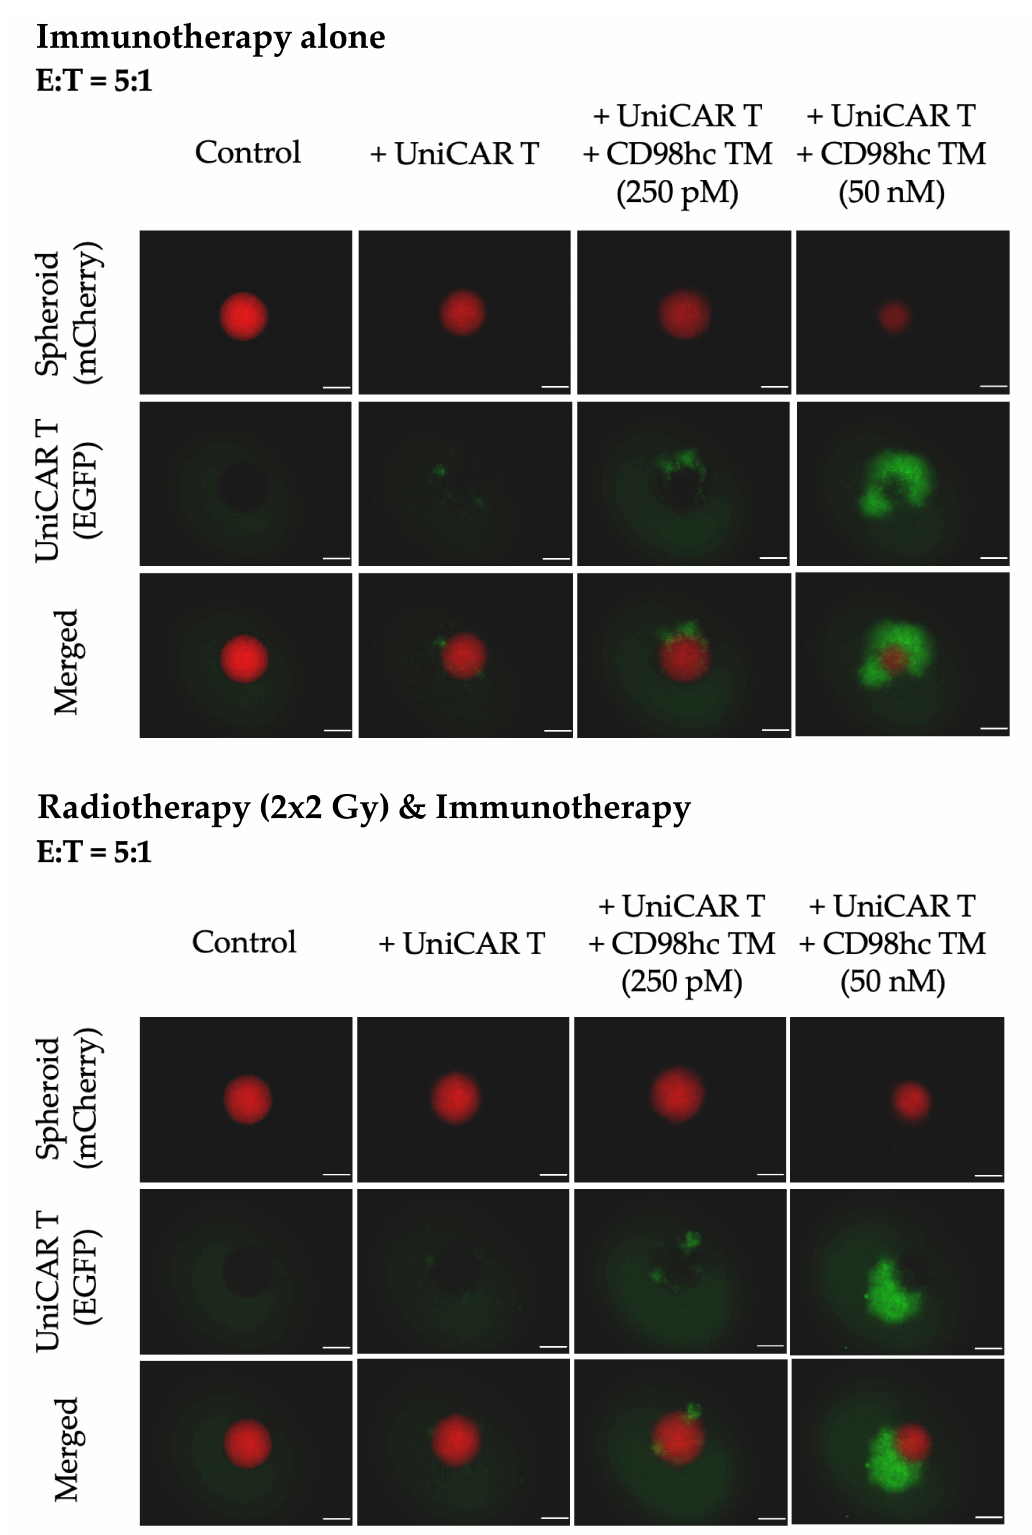
Figure 5. Representative fluorescence images of Cal33 RR spheroids treated with UniCAR T cells in the presence or absence of different CD98hc TM concentrations showing the activation and increase in the EGFP signal of UniCAR T cells in both immunotherapy alone or combination conditions. Fluorescence images were taken with Axio Observer Z1 (Zeiss, Jena, Germany). Cal33 RR spheroid: red fluorescence, UniCAR T: green fluorescence. Scale bar: 200 µ